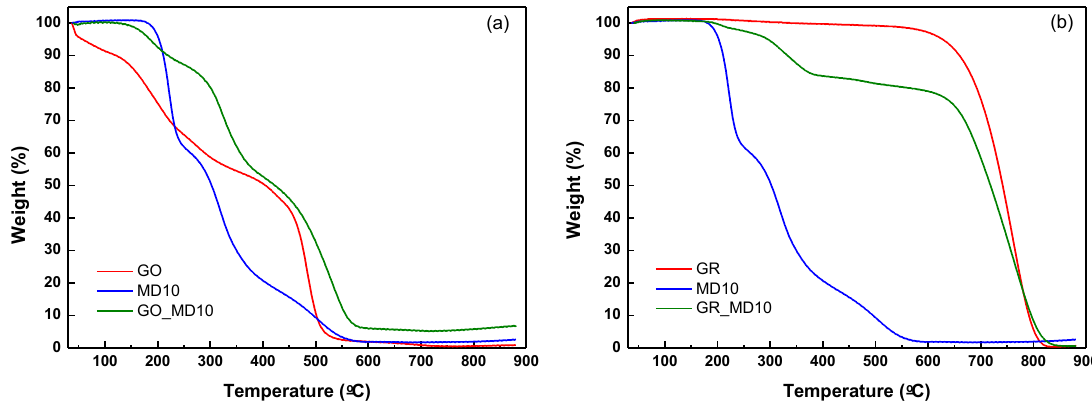
Figure 5. Thermogravimetric (TGA) analysis of ( a ) graphene oxide hybrid sample GO_MD10 compared to GO and MD10 polymers; and ( b ) graphene hybrid sample, GR_MD10 compared to, MD10 and GR. Table 1. Characteristic parameters of the thermal degradation of hybrid materials, the decomposition temperatures at 5% weight loss (T d5 ) and the temperatures of the maximum rate of weight loss for